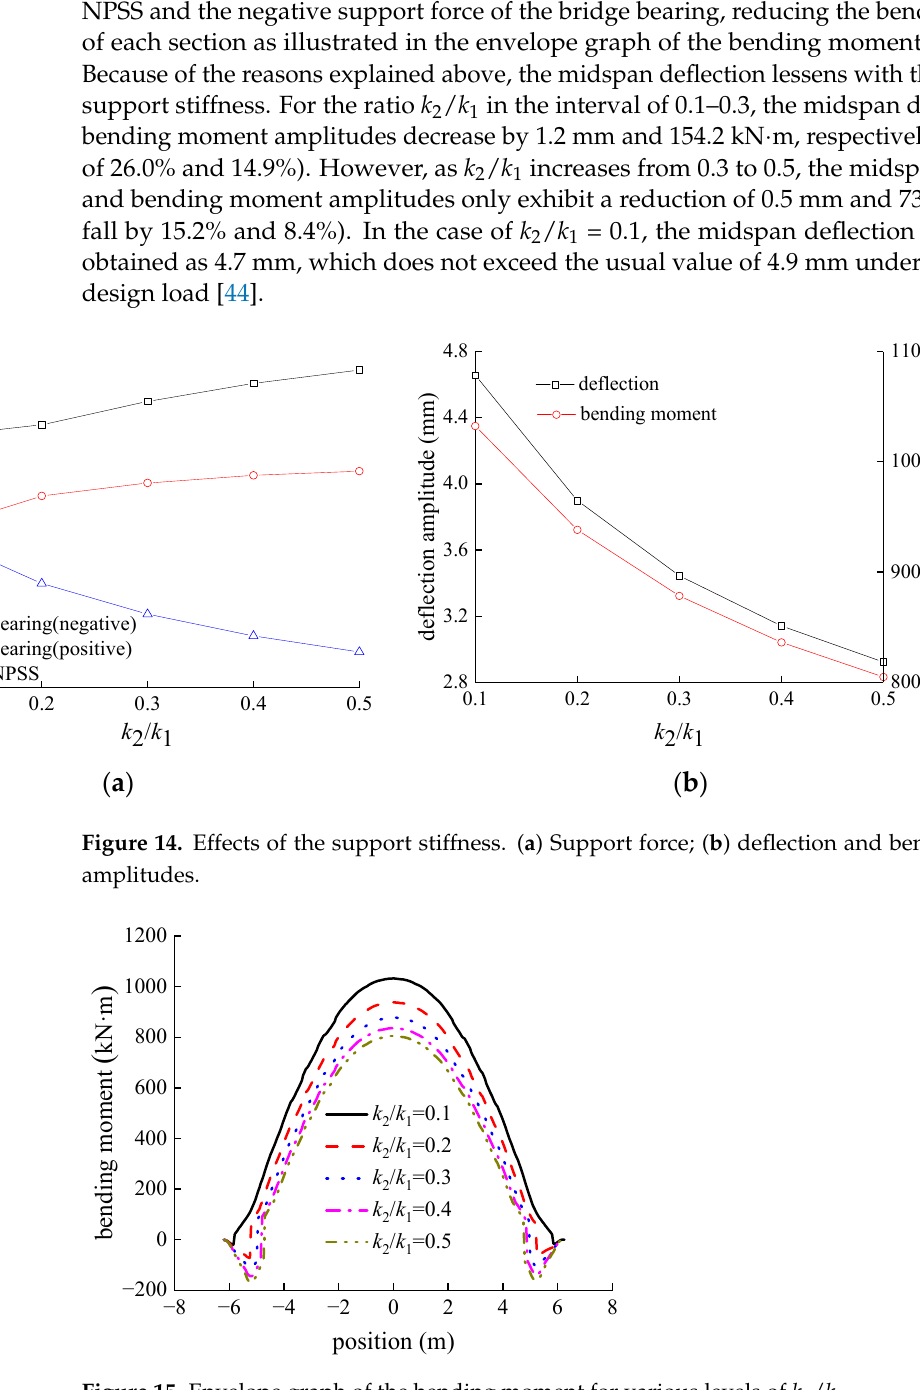
( b ) Figure 16. Effects of the installation location. ( a ) Support force; ( b ) deflection and bending moment amplitudes. As shown in Figure 16a, with the growth of l 1 , the supporting force amplitudes of the bridge bearing and the NPSS vary approximately linearly, where the positive supporting force amplitude of the bridge bearing lessens and the supporting force amplitude of the NPSS grows. For the case of l 1 = 0.73 m, the support forces of the bridge bearing and the NPSS are approximately equal. As the value of l 1 ranges from 0.4 m to 0.8 m, the support forces of the bridge bearing and the NPSS demonstrate the changes of 60.7 kN and 75.0 kN, respectively (i.e., the percentage alterations of 22.2% and 48.5%). The illustrated results in Figure 16b reveal that the midspan deflection and bending moment amplitudes lessen linearly with the increase of l 1 such that the reduction rates in order are 2.4 mm/m and 291.8 kN·m/m. As the value of l 1 increases from 0.4 m to 0.8 m, the midspan deflection and bending moment amplitudes lessen by 1.0 mm and 116.6 kN·m, respectively, signifying a reduction of 17.1% and 10.1%. Thus, the installation location of the NPSS plays a vital role in the strengthening ef- fect; nevertheless, in the case of k 2 / k 1 = 0.1, l 1 must be greater than 0.7 m to meet the re- quirements of the bridge deflection.